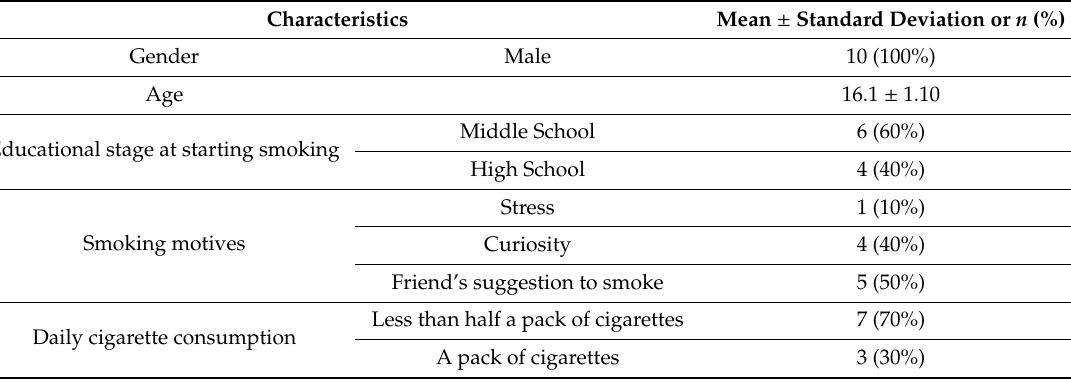
Table 1. General